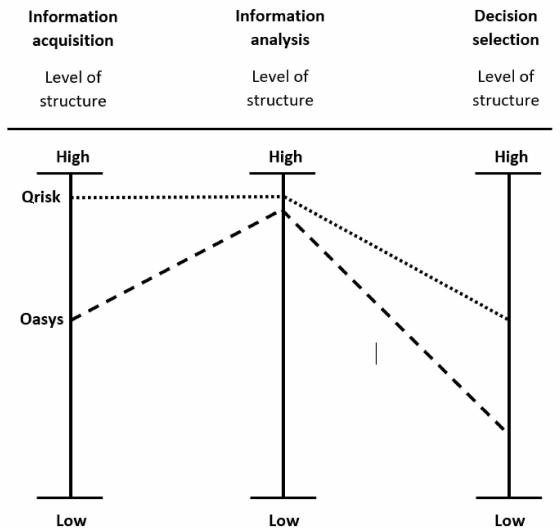
Figure 1. Structure operating at di ff erent assessment stages for the QRISK3 and O ff ender Assessment System (Oasys) actuarial tools